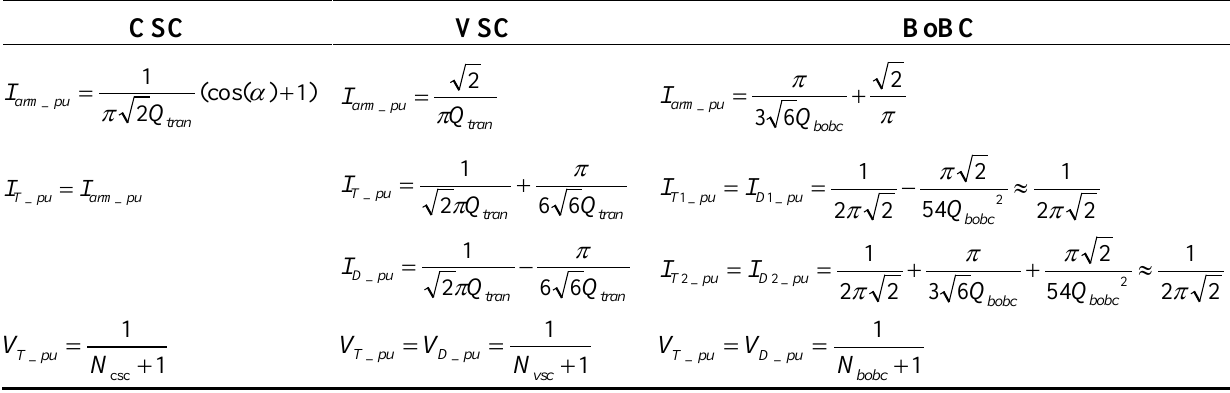
Table 2. Analytical relationships of power semiconductor per-unitized currents and